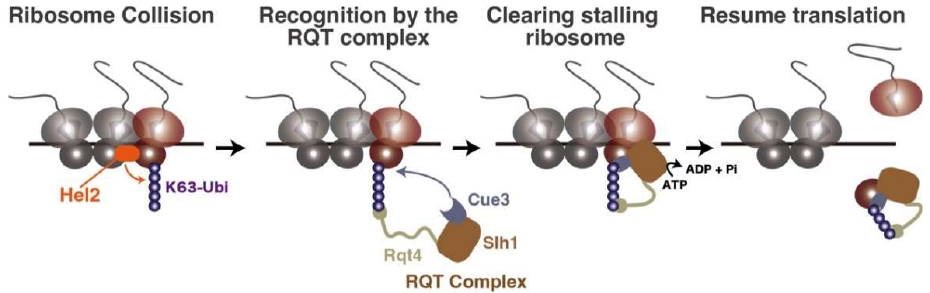
Figure 2. Ribosome quality control triggering step. The ribosome collision is recognized by E3 ligase Hel2, which elongates the K63-linked poly-ubiquitination on the ribosomal protein uS10. The K63-linked polyubiquitination is recognized by the RQT complex via its components Cue3 and Rqt4, inducing the non-canonical ribosome dissociation for the leading stalling ribosome to resume